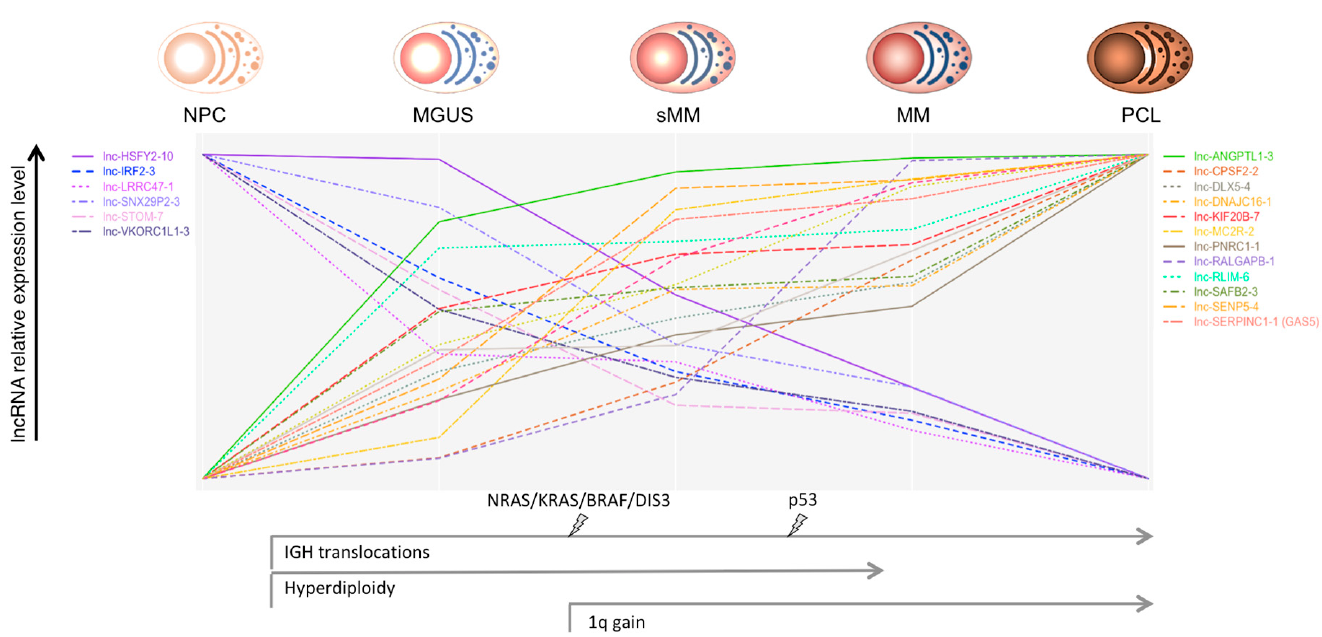
Figure 1. Oncogenic events, such as the main chromosomal aberrations and gene mutations, through the different stages of plasma cell (PC) dyscrasias are represented. The relative expression level (scaled to common y-axis range on the upper and lower values) of the long ncRNAs (lncRNAs) deregulated through the progressive stages of PC dyscrasias is shown [26]. Abbreviations: NPC = normal plasma cell; MGUS = monoclonal gammopathy of undetermined significance; sMM = smoldering multiple myeloma; MM = multiple myeloma; PCL = plasma cell leukemia.